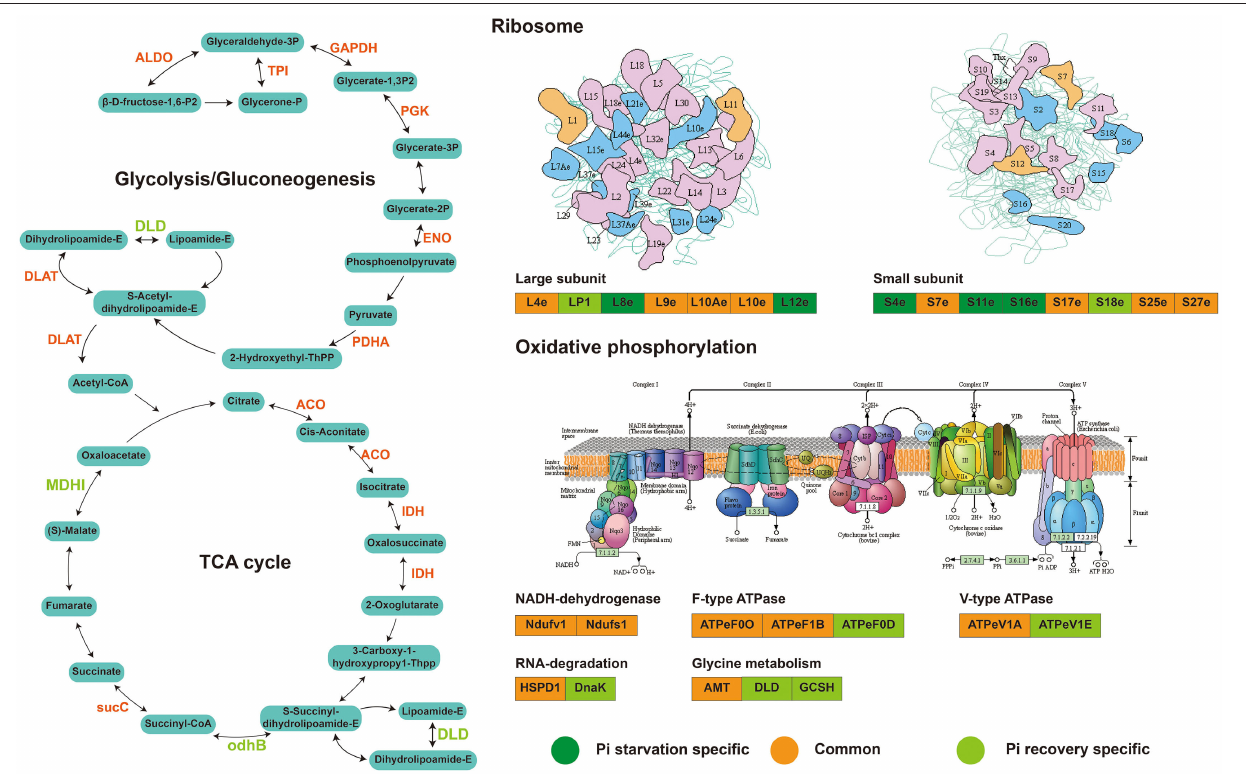
FIGURE 10 | Major succinylation-mediated metabolic processes and proteins involved in short-term Pi starvation and recovery, as depicted by succinyl-proteome analyses. For details of the proteins and their abbreviations, see Supplementary Table 14